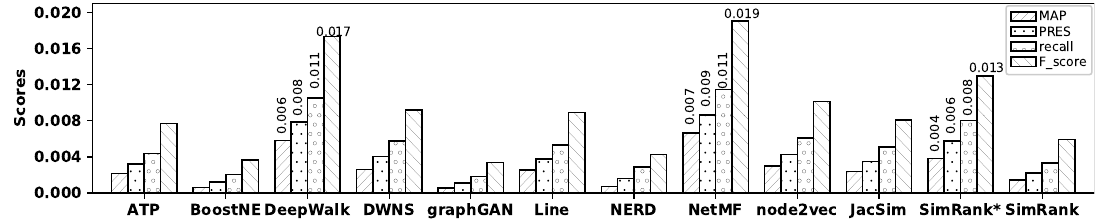
Figure 6. Accuracy of embedding methods and similarity measures with the BlogCatalog dataset. Table 4. Precision values with the BlogCatalog dataset.